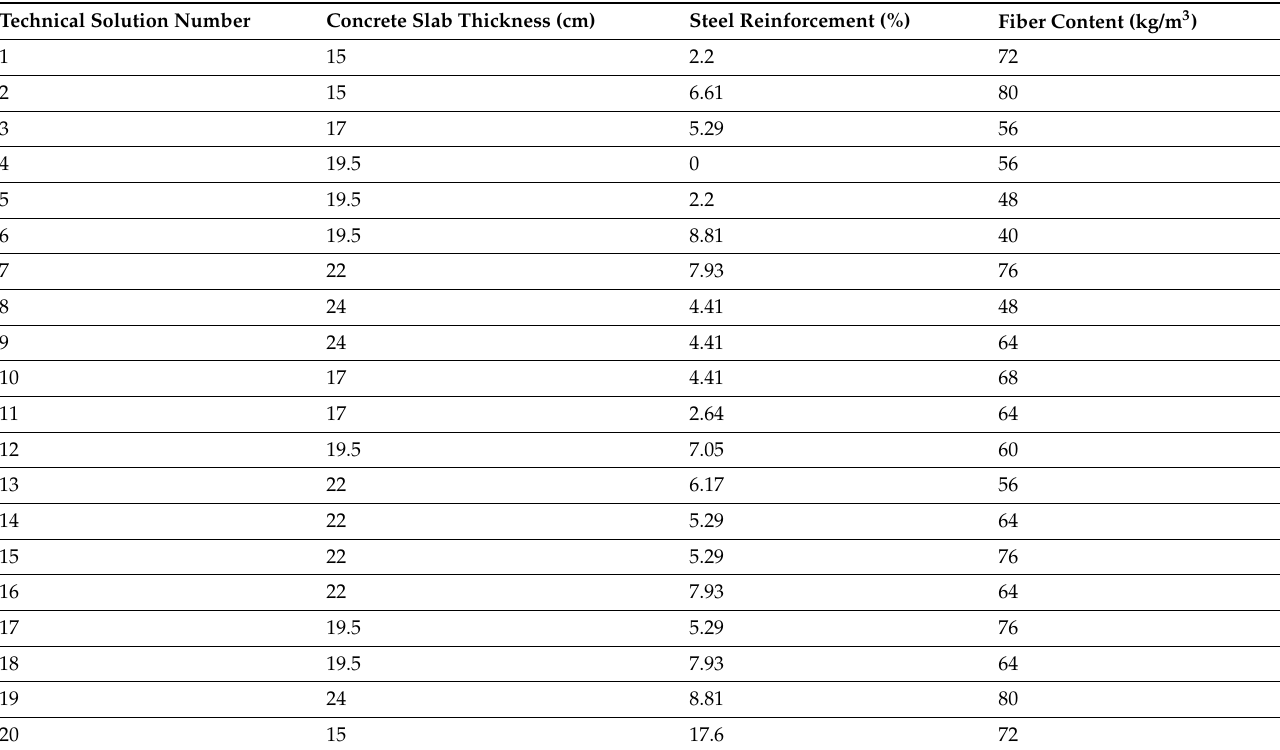
Figure 2. Geometry and dimensions of the Railway Track Mockup. Table 1. All technical solutions studied (step